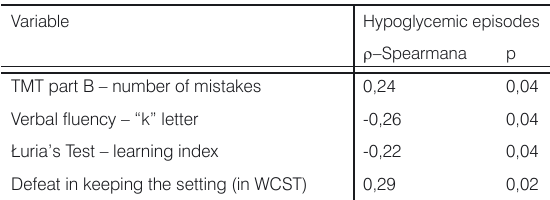
Table 5. The ρ -Spearman’s correlation coefficient for hypoglycemic episodes and cognitive